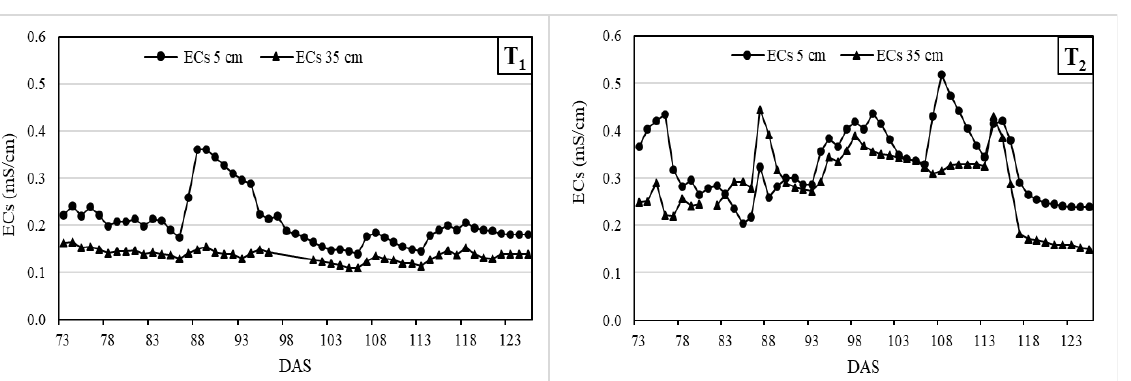
Figure 4. Daily patterns of soil water contents (SWCs) at 5 and 35 cm depths under fresh water (T 1 ) and domestic treated wastewater (T 2 ). Өcc: soil moisture content at field capacity; Өpfp: soil moisture content at permanent wilting point; DAS: days after sowing.